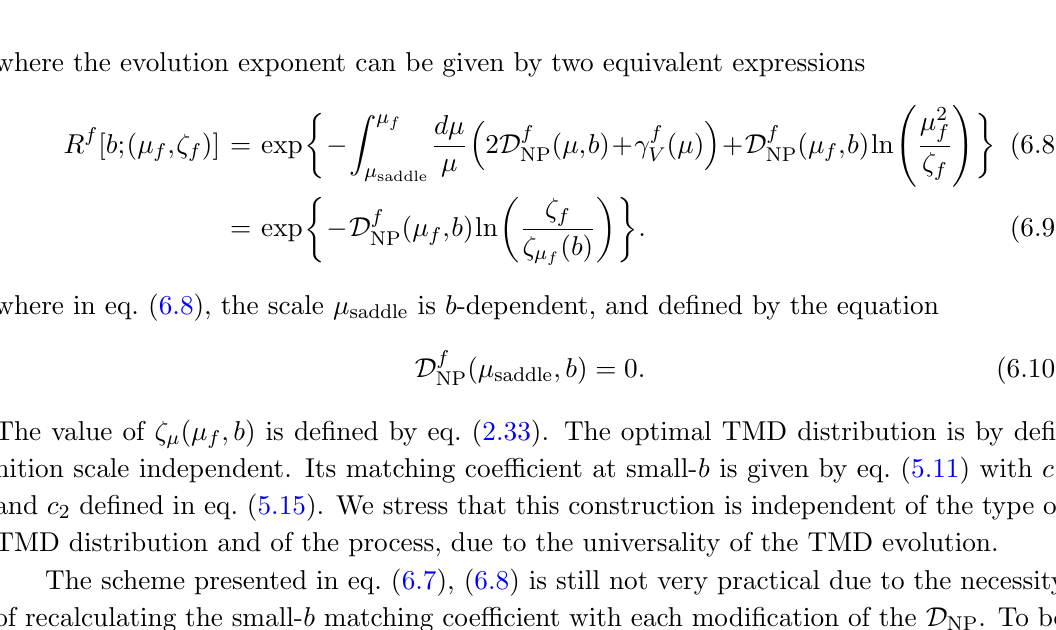
Figure 10 . Comparison of error bands obtained by the scale-variations for cross-sections given by (6.2) (top), (6.5) (middle), (6.12) (bottom) at NNLO. Here, the kinematics bin-integration, etc., is for Drell-Yan process measured at E288 experiment at E beam = 200GeV and Q = 6 (cid:0) 7GeV